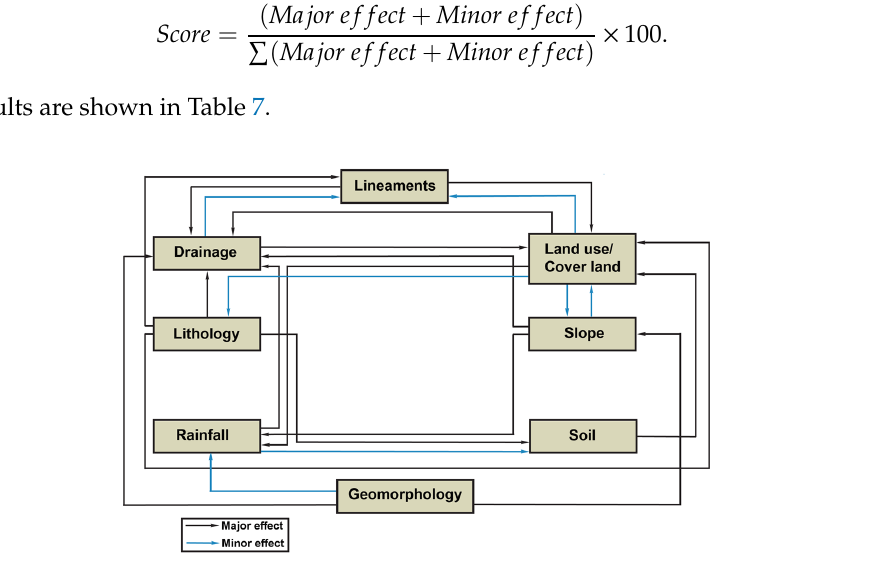
Table 7. The values of major, minor, relative e ff ects and proposed weight of influencing